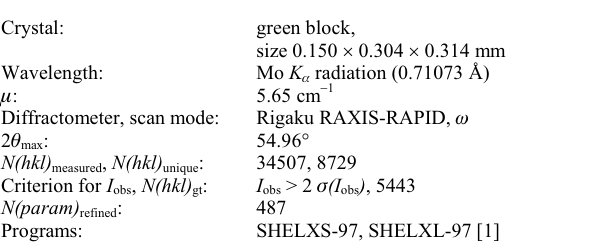
Table 1. Data collection and handling.